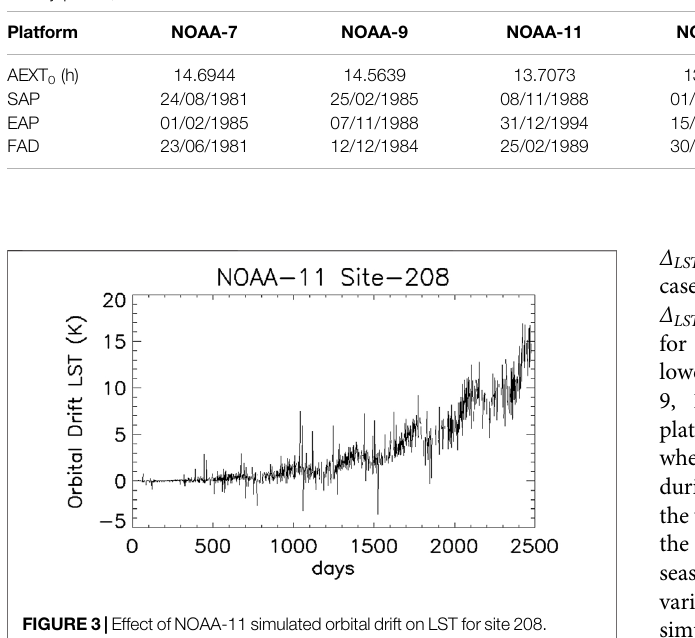
FIGURE3| EffectofNOAA-11simulatedorbitaldriftonLSTforsite208.